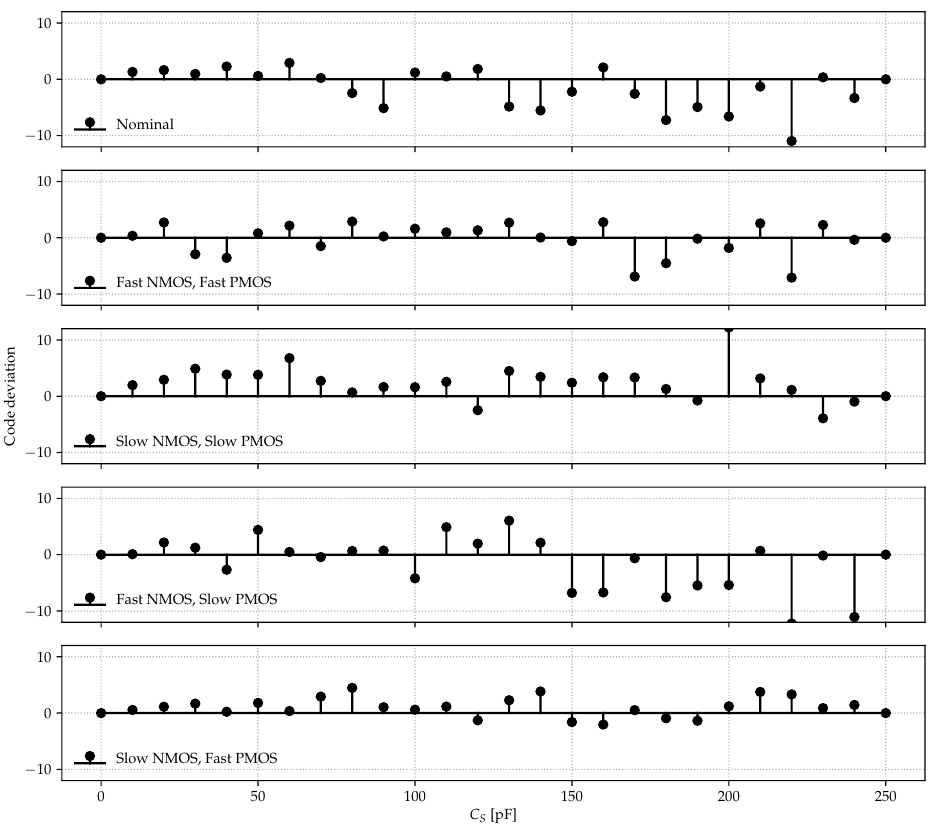
Figure 10. CDC differential non-linearity (DNL) against process corners. The output register width is 16 bits.